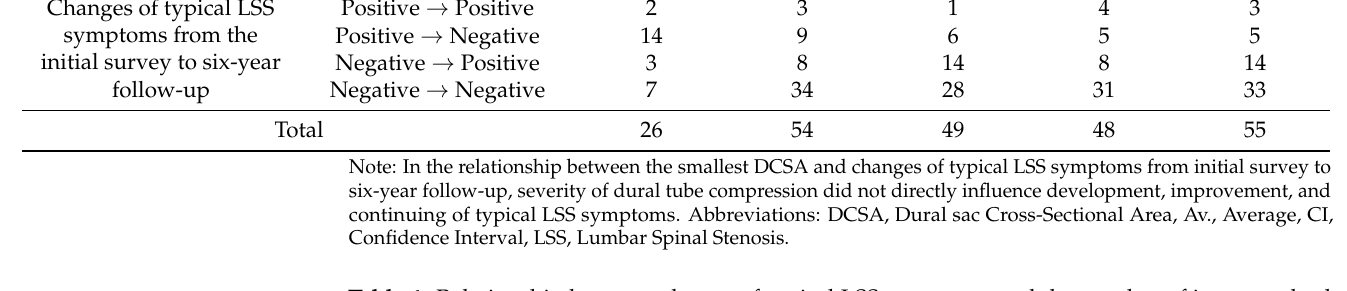
Table 4. Relationship between change of typical LSS symptoms and the number of intervertebral discs whose DCSA was less than 50 mm 2 .